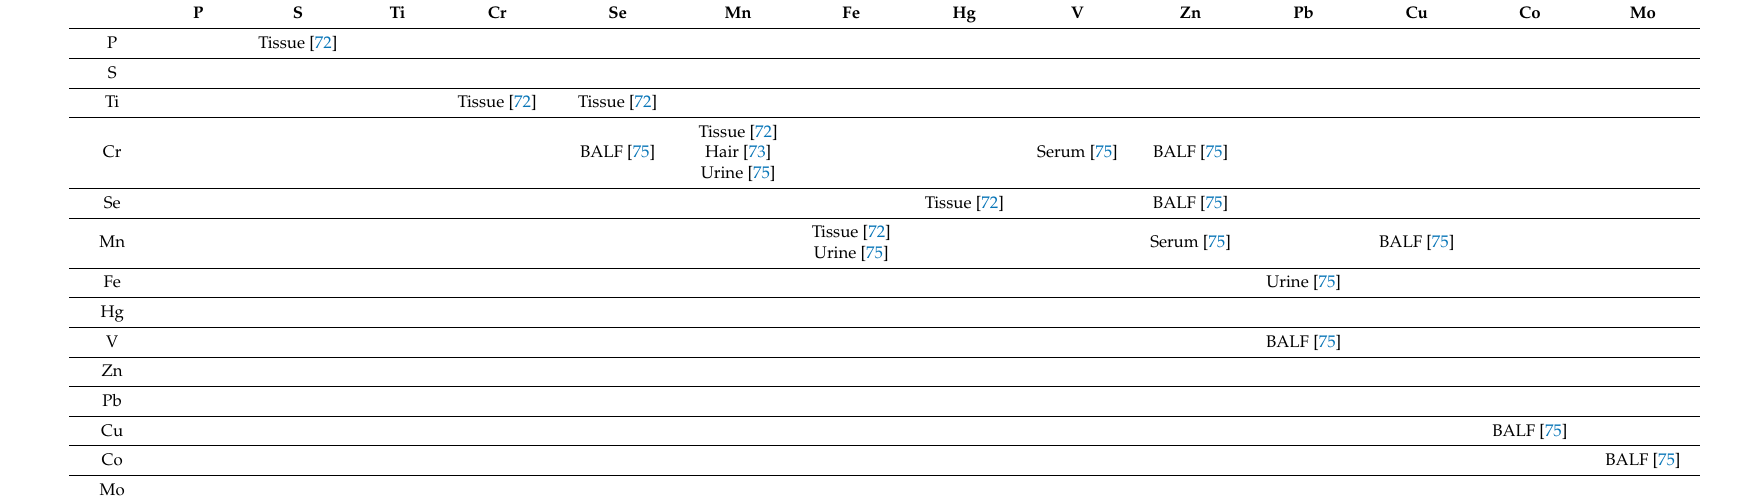
Table 2. Significant correlations between elements in the biofluids and tissues of lung cancer